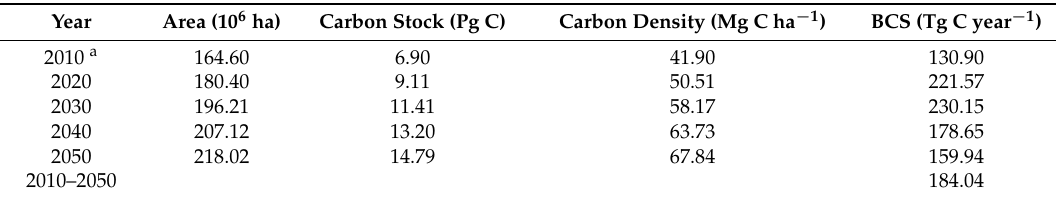
Table 3. Projected forest area, biomass carbon stock (BCS), and carbon sequestration of China’s forests between 2010 and